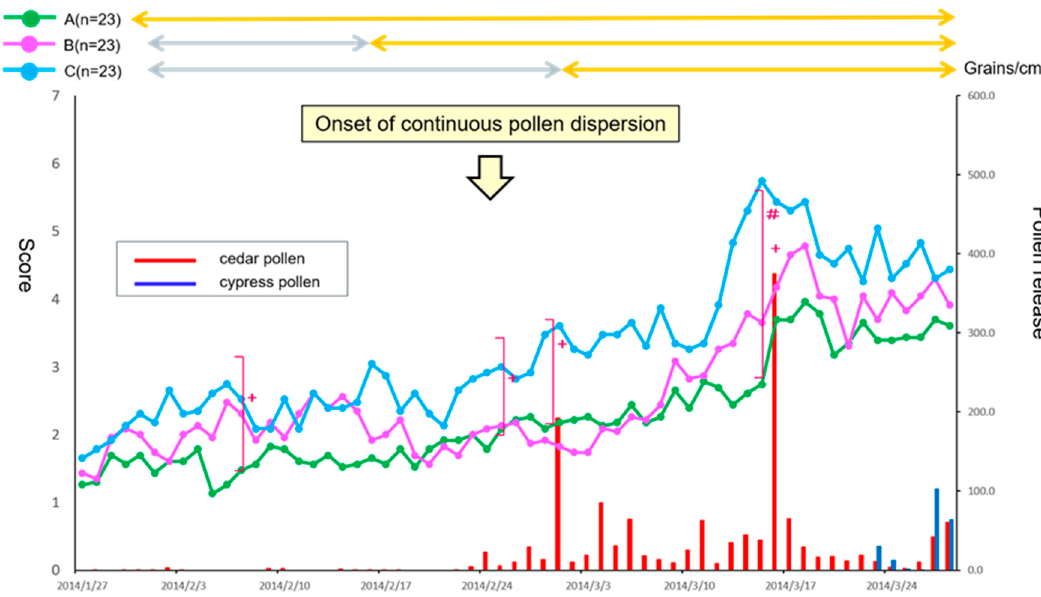
Figure 1. Comparison of primary endpoint efficacy between the treatment groups and fluctuation of cedar pollen dispersal. The daily reflective total naso-ocular symptom score (TSS) from baseline in patients with 3-weeks of prophylactic treatment (Group A: green), 1-week of prophylactic treatment (Group B: magenta) or post-onset treatment (Group C: cyan) with fluticasone furoate nasal spray (FFNS) is shown. Results are expressed as median values. The fluctuation in cedar pollen dispersal is shown by the red bars. A Kruskal-Wallis test was used to compare data between the three groups (+ p < 0.05). A Dunn’s test was further used to compare data between each group (# p < 0.05).